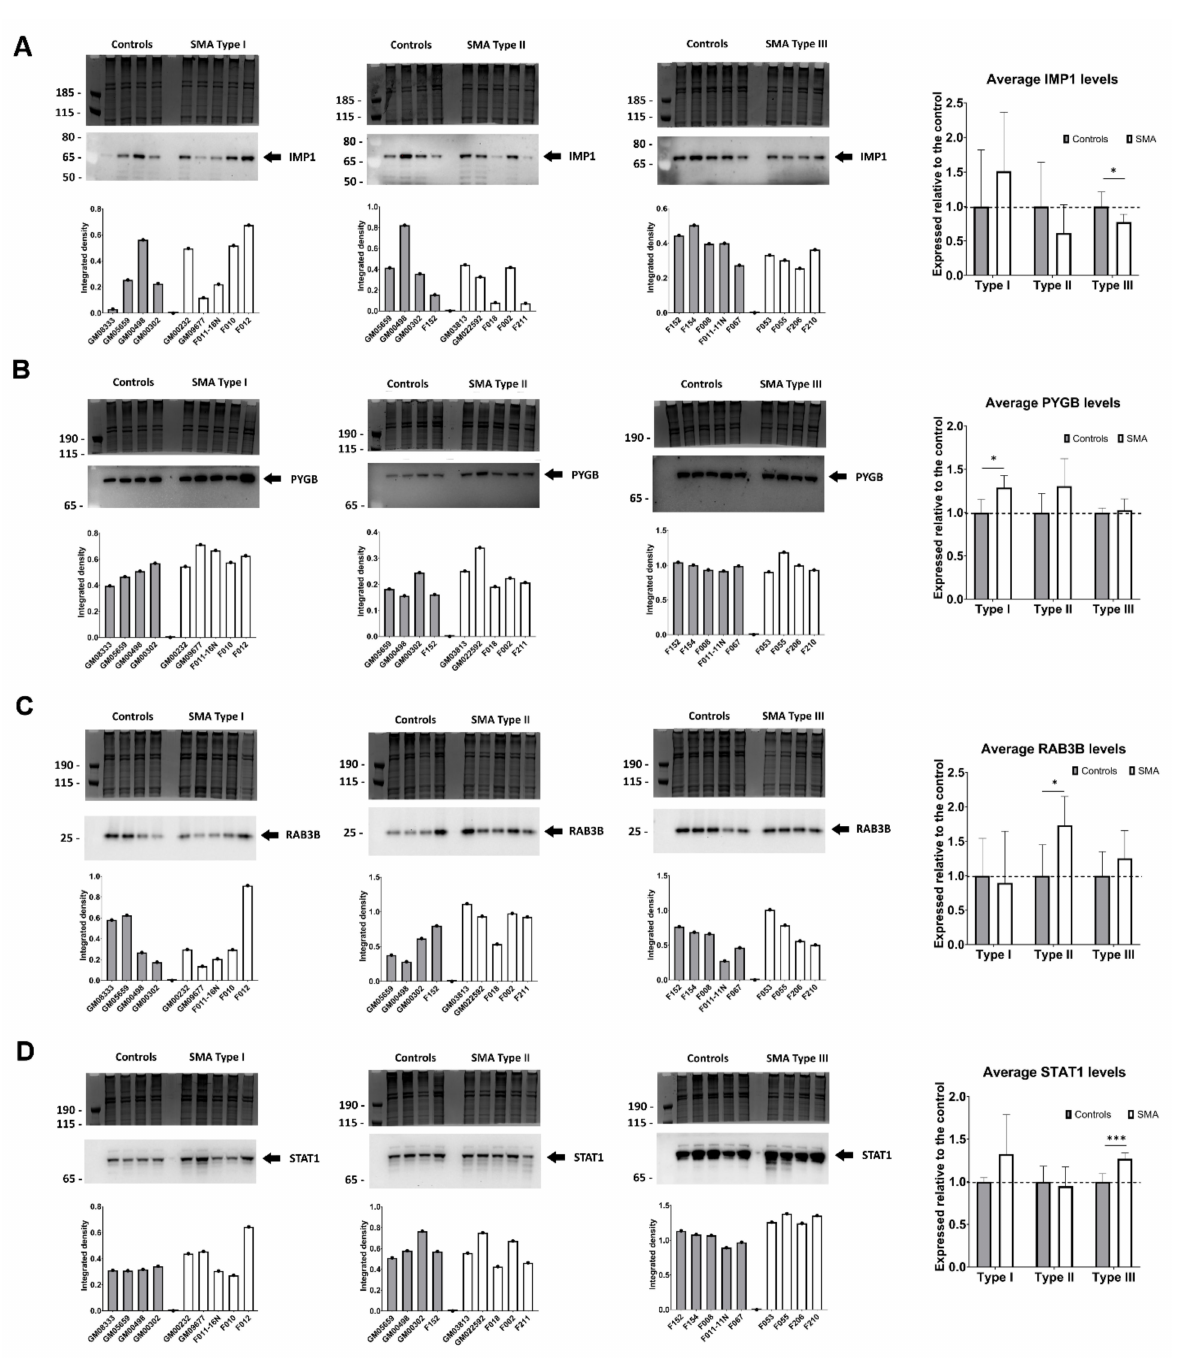
Figure 5. Verification of differential expression of proteins selected from the BioLayout clusters as potential markers for SMA type. Representative Western blots showing levels of ( A ) IMP1, ( B ) PYGB, ( C ) RAB3B and ( D ) STAT1 in each SMA type. Graphs below each Western blot represent the integrated density of antibody-reactive bands/densitometry measurements of a Coomassie-stained gel (i.e., total protein loading control) for individual samples. The summary graphs give the average values for each of the proteins (IMP1, PYGB, RAB3B and STAT1) in each SMA type relative to their respective controls, with a dashed line indicating normalised SMN levels across all control fibroblasts. Error bars show the standard deviation from the mean. *** p < 0.001; * p <